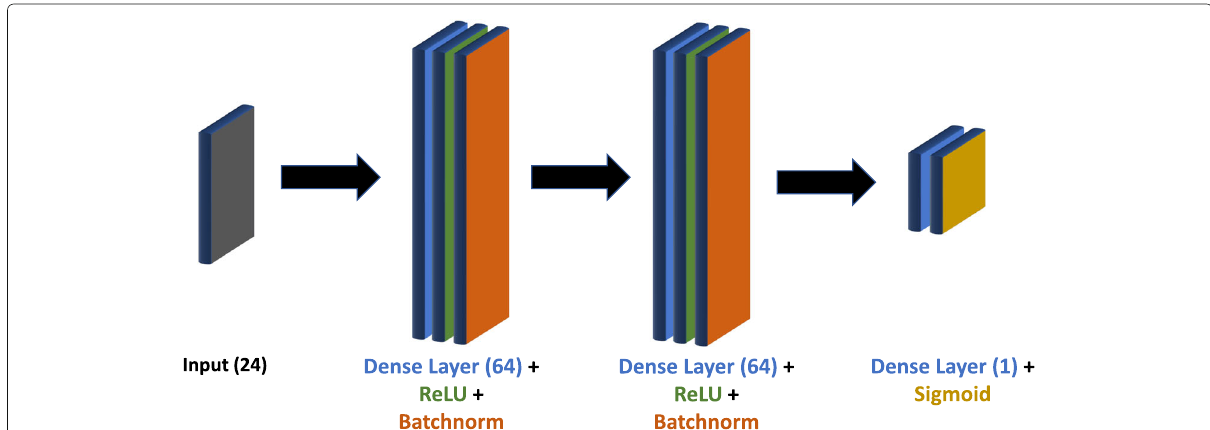
Fig. 6 Neural Network Architecture: Network architecture for the DL moral decision model. Batchnorm signifies a batch normalization layer